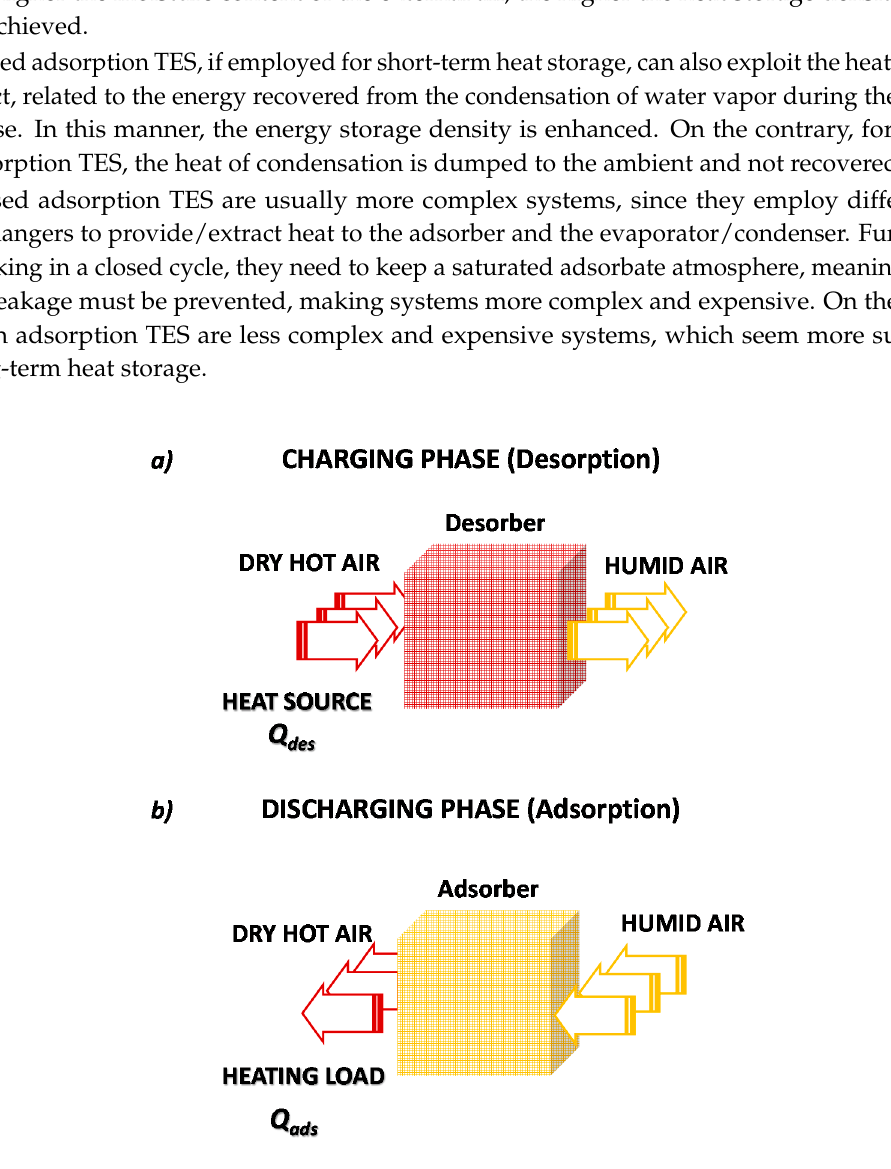
Figure 6. An open adsorption heat storage cycle: ( a ) charging phase; ( b ) discharging phase.